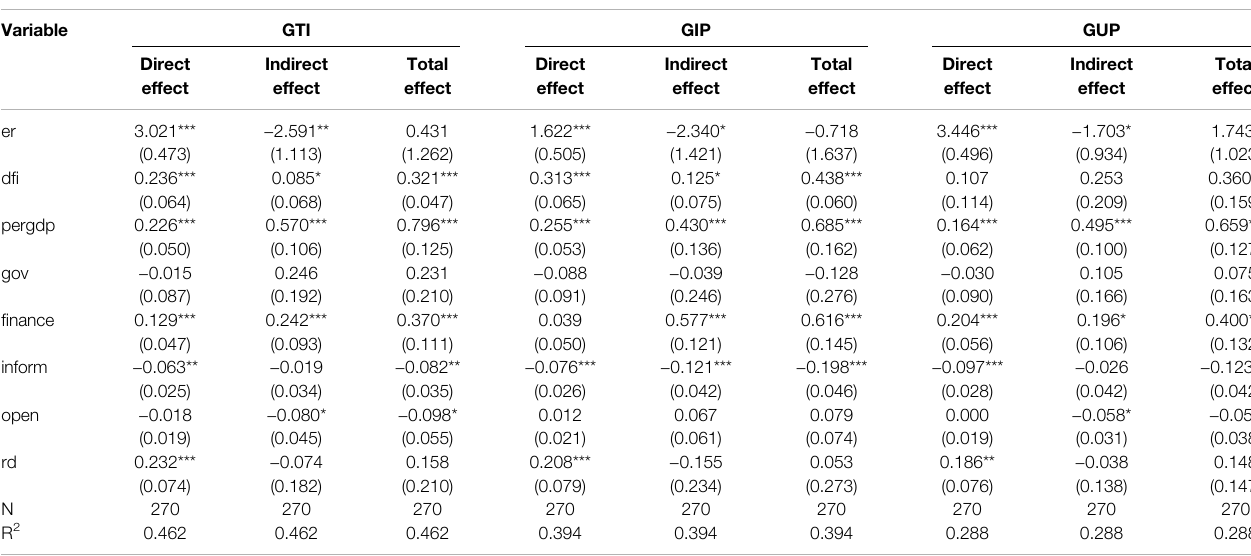
TABLE 4 | Estimation results of decomposition effects.